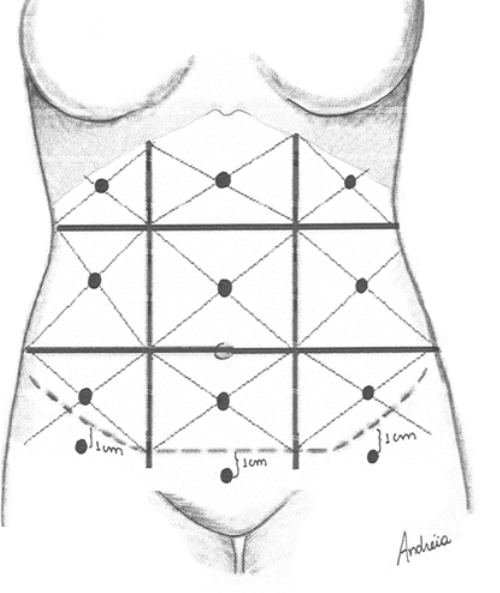
FIGURE 2 : Illustration demonstrating the points where the sensibility evaluation was performed